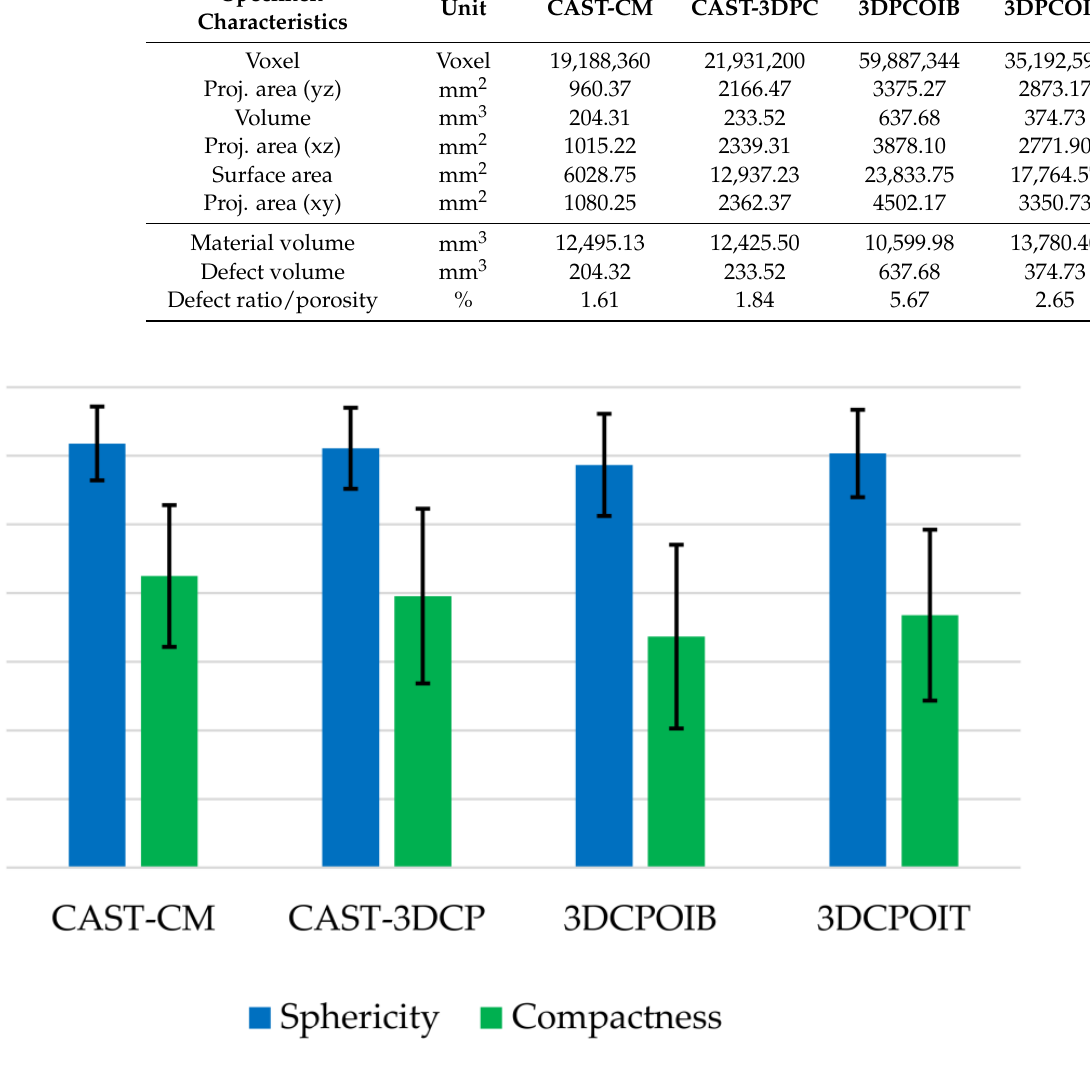
Figure 8. Sphericity and compactness means of all specimen groups obtained from µ -CT scanning. Error bars indicate standard deviation. Values are unitless; however, a value of 1 equals an ideal spherical pore space.